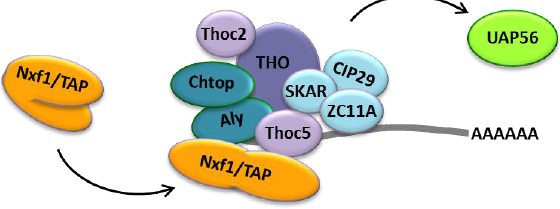
Figure 3. Binding of Nxf1/TAP to Aly and Thoc5 induces a conformational change in the protein which allows RNA binding [60] and leads to the release of UAP56.